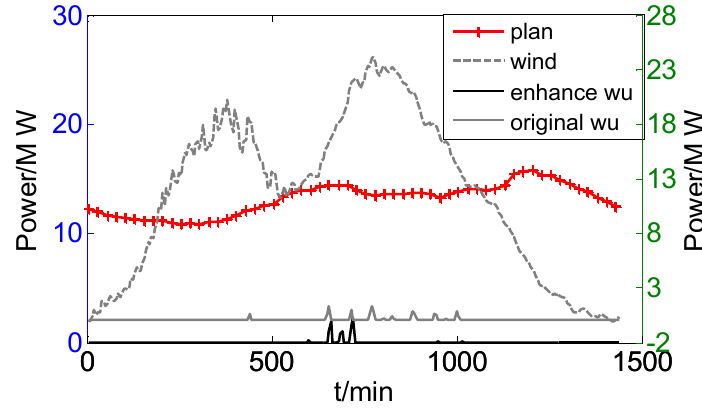
Figure 17. Results of the first objective after increasing the weighting.